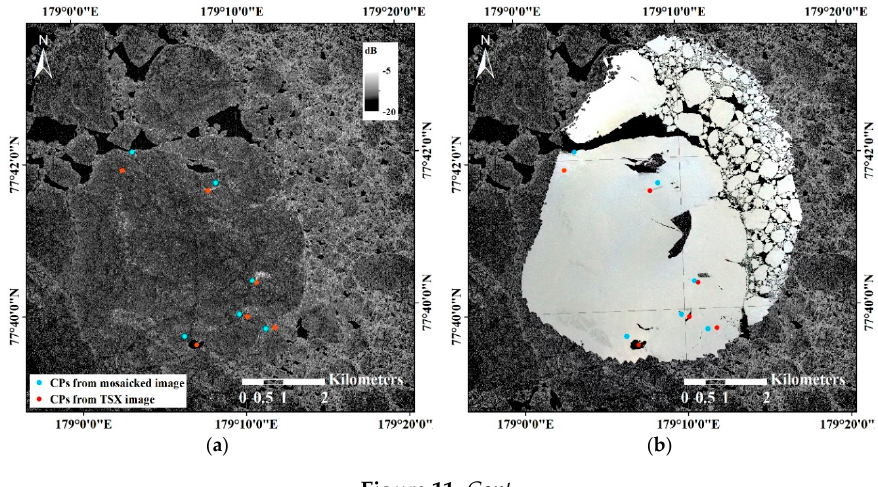
Figure 10. Comparison between the geographic coordinates of trajectories from the IBRV Araon anchored to the main ice and from the ice mass balance buoy (IMB) deployed on the same ice floe, recorded at the time of consistent heading